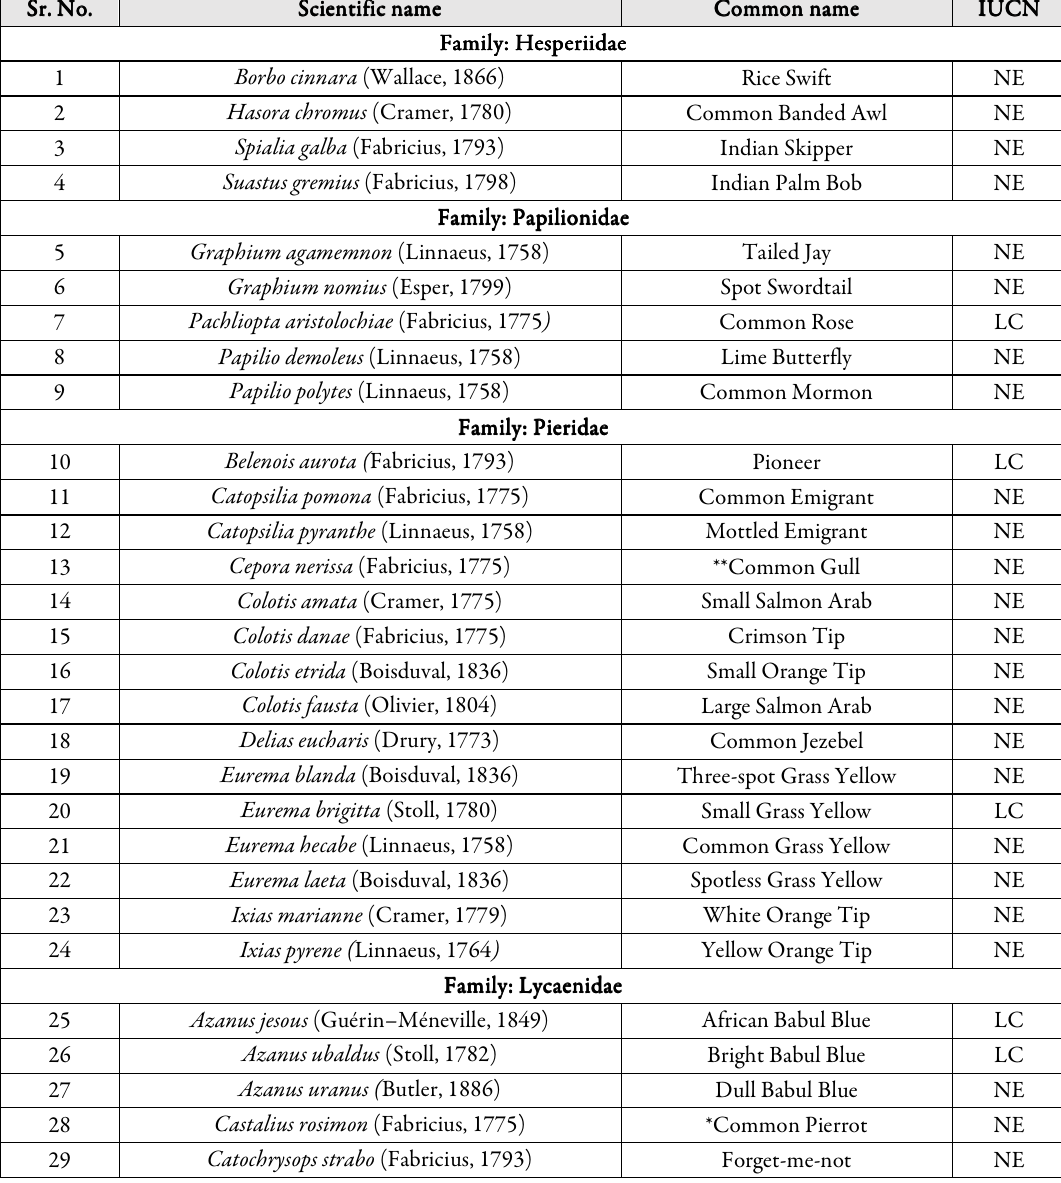
Table 2. Family-wise checklist of butterflies observed in the study area with its status in IUCN and WPA